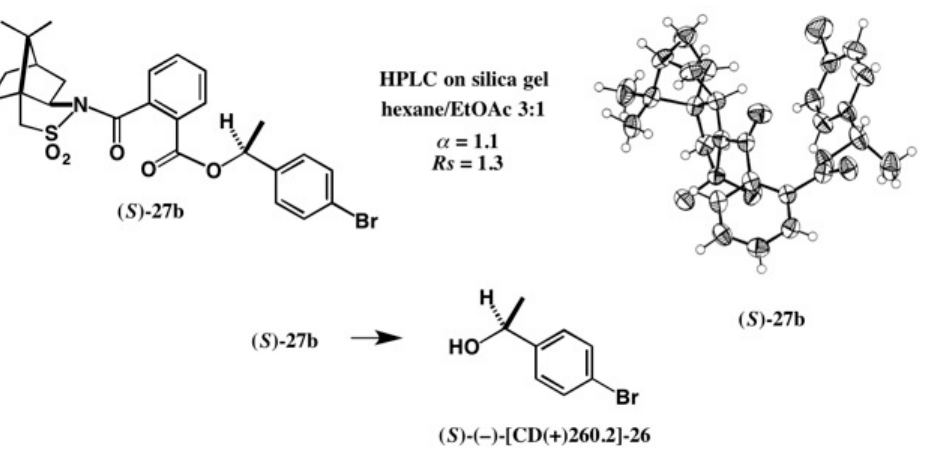
Figure 18. Preparation and HPLC separation of esters 27a and 27b , and the AC determination of ester ( S )- 27b by X-ray analysis. From ester ( S )- 27b , alcohol ( S )-( − )- 26 was obtained. ORTEP drawing, reprinted from [31].